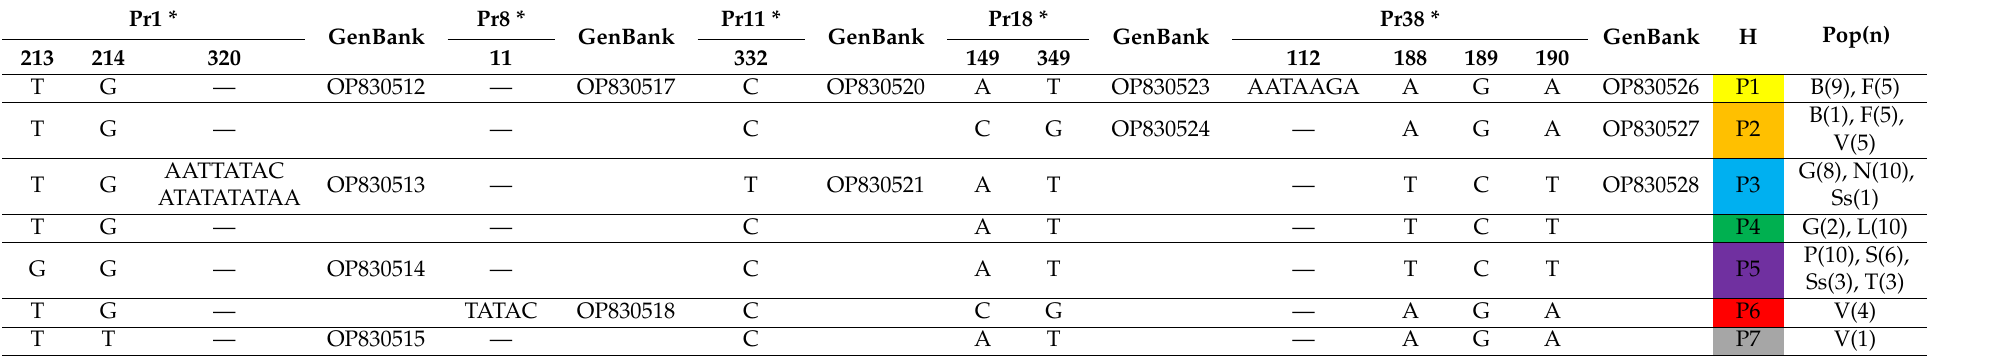
Table 3. Mutations in the five selected cpDNA markers and corresponding haplotypes in Genista etnensis populations. See also Table 1 for the molecular markers’ information and Figure 2 for the haplotypes’ geographic